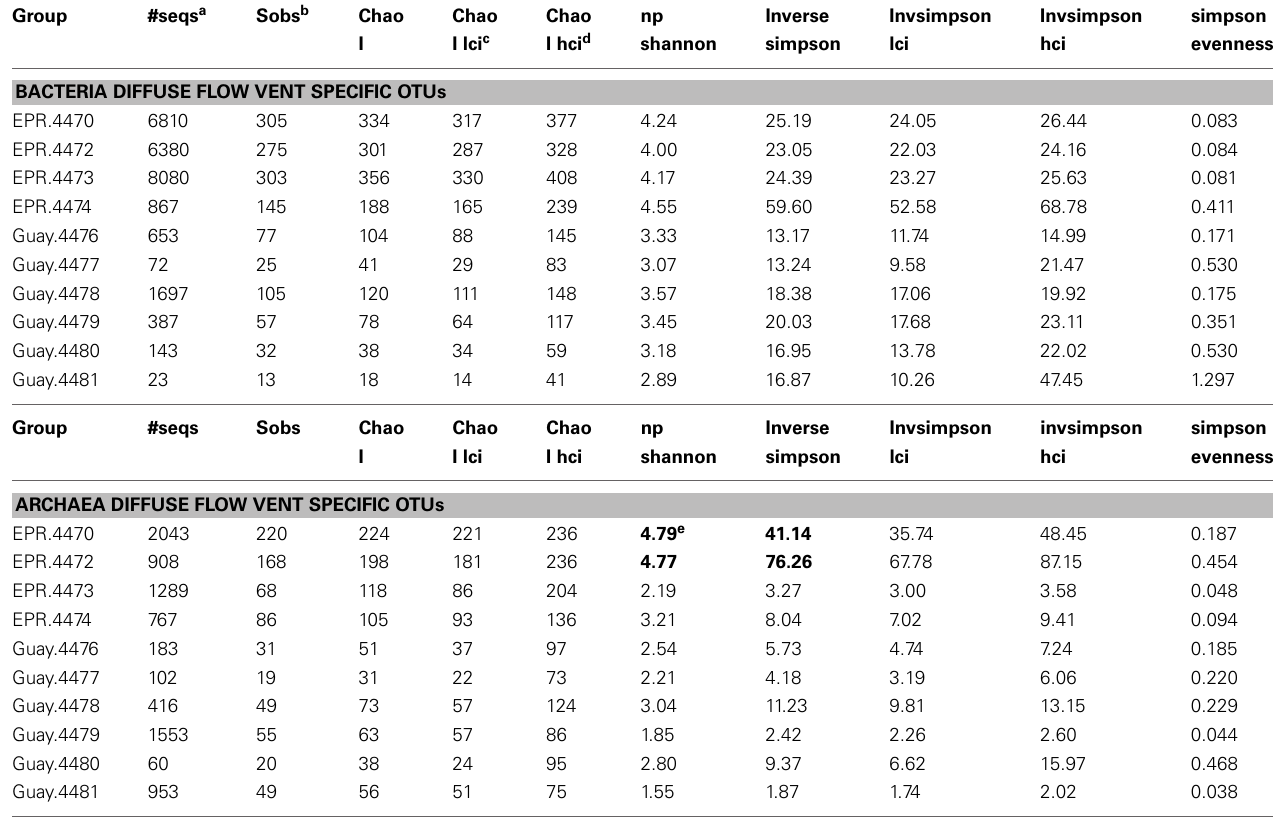
Table 5 | Diversity estimates from 16S rRNA amplicon libraries of diffuse flow vent samples collected at 9 ◦ N East Pacific Rise (EPR) and Guaymas Basin (Guay) hydrothermal vent